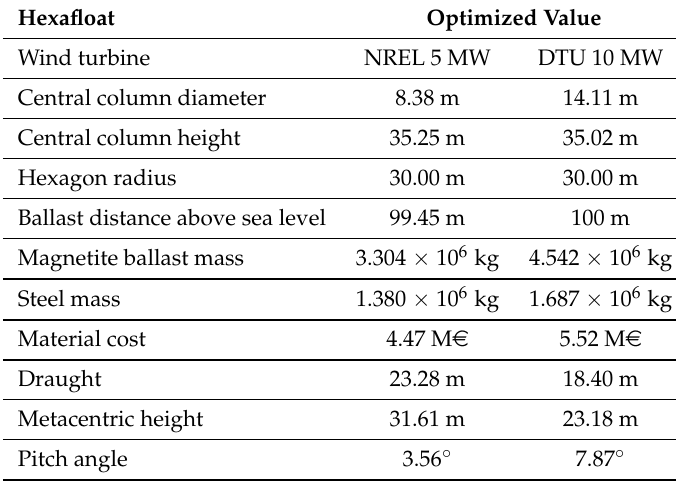
Table 4. Dimensions and main hydrostatic parameters for Hexafloat